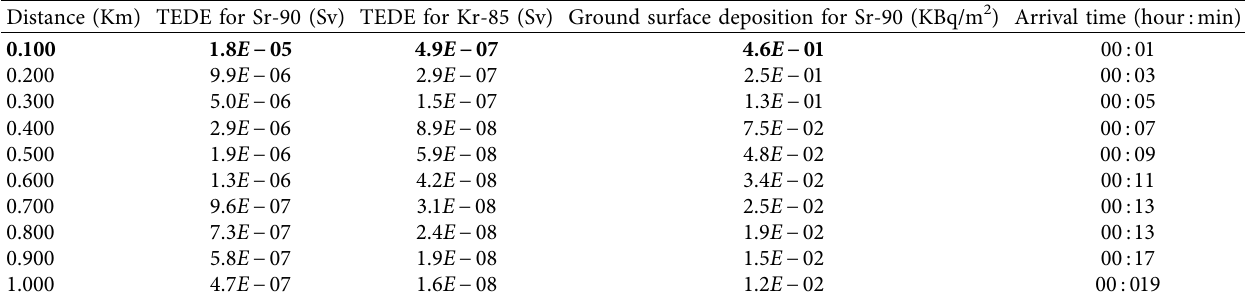
Figure 5: Plume contour showing areas that fall within the path of the radionuclide emission. Table 5: Total effective dose and other plume centerline parameters at different arrival times.